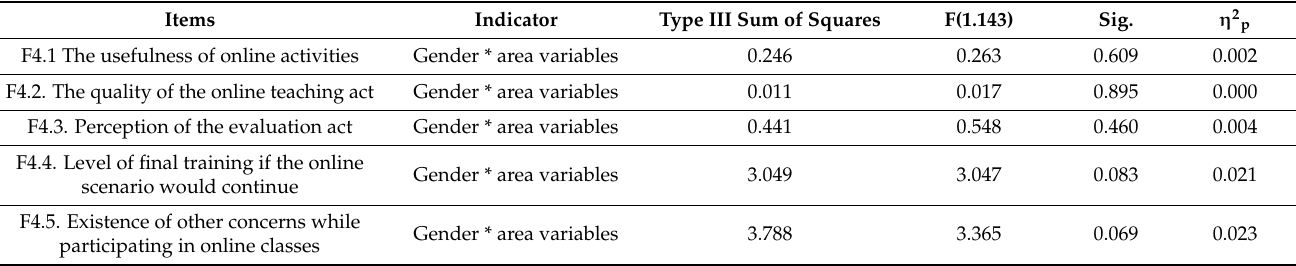
Table 9. Tests of between-subjects effects—the cumulative effect of gender variables * area variables on F4 factor